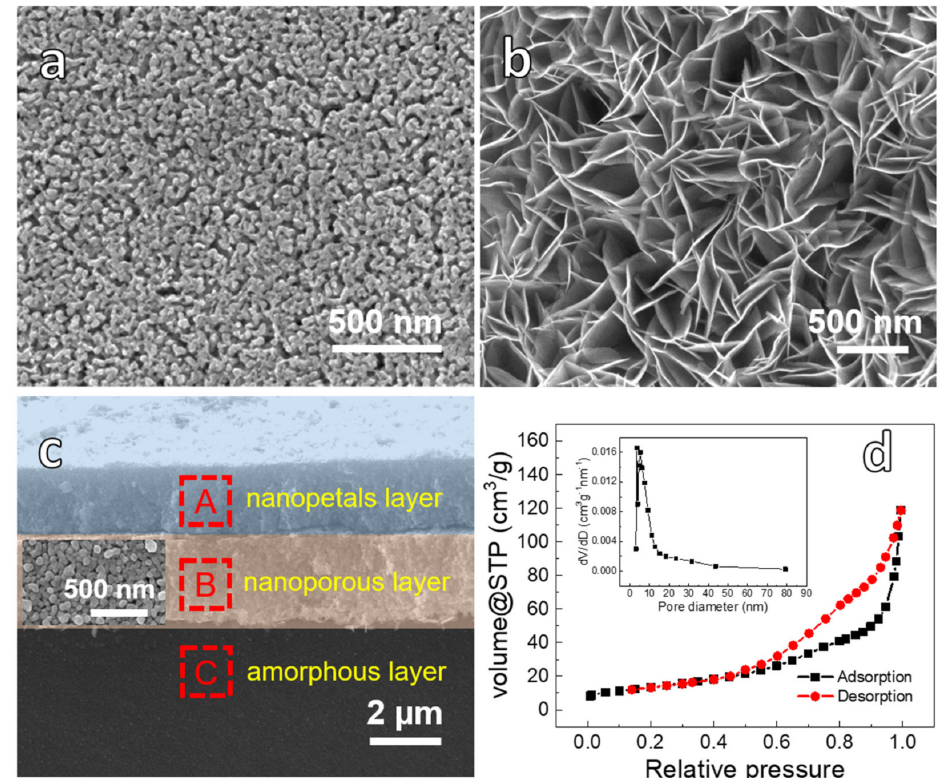
Figure 1. ( a ) SEM images of Cu 40 Zr 60 amorphous alloy ribbon de-alloyed in 0.05 M HF for 2 h; The composite sample via deposition at − 0.8 V for 30 min followed by the calcination: ( b ) Plan-view SEM images; ( c ) Cross-sectional SEM image; ( d ) Nitrogen adsorption-desorption curve and pore size distribution of Co 3 O 4